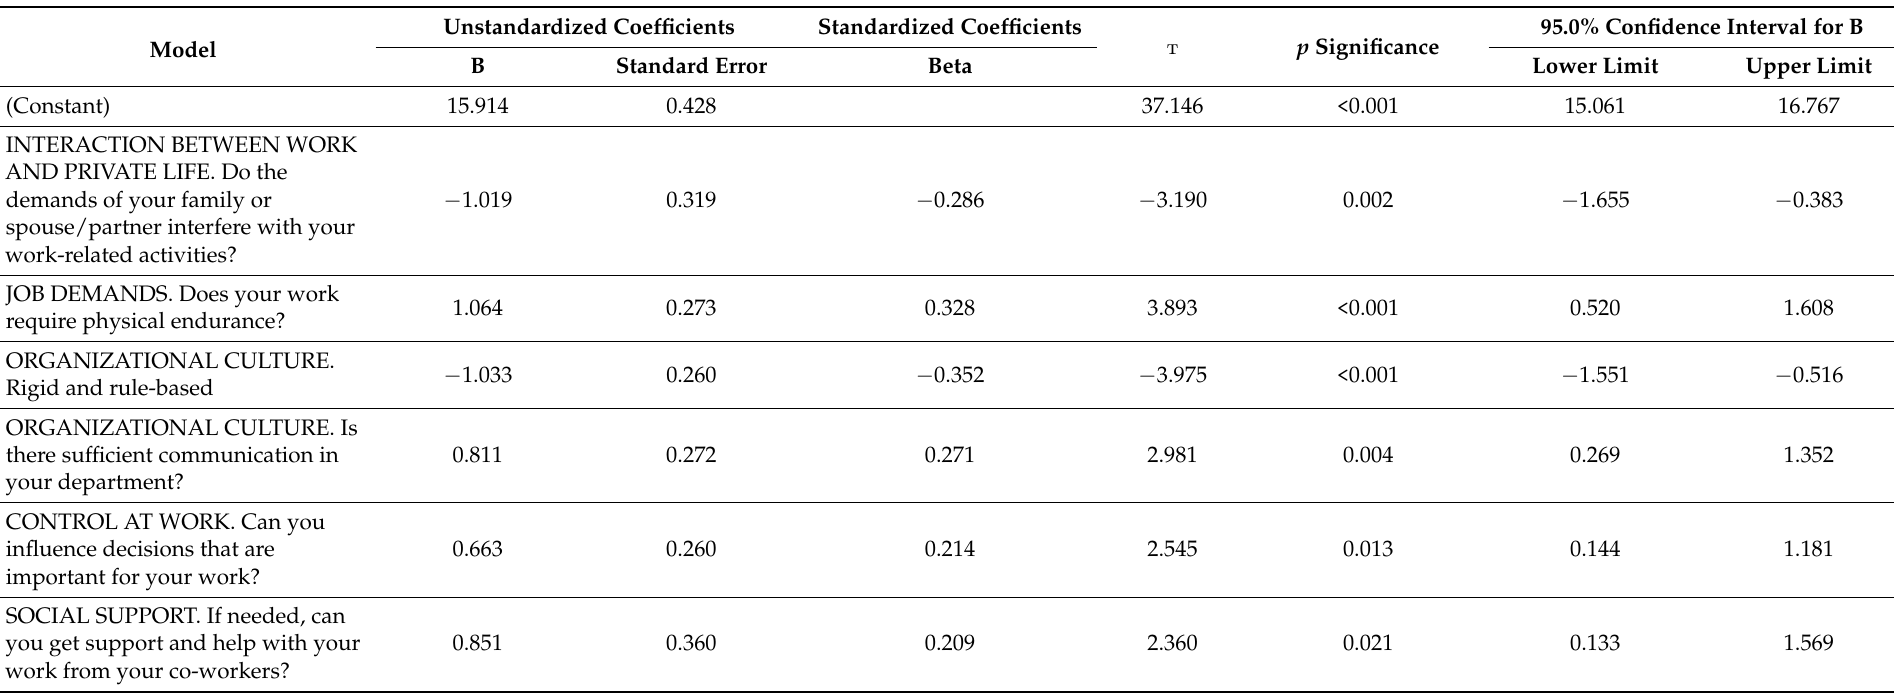
Table 8. Contribution of the assessments of psychosocial factors (coefficients of the regression equation) to the variability of loggers’ working